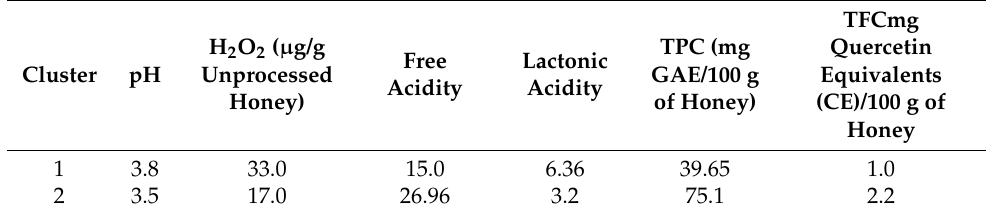
Table 3. Centroids of the 2 clusters formed by the physicochemical analysis of the 20 citrus honey samples.